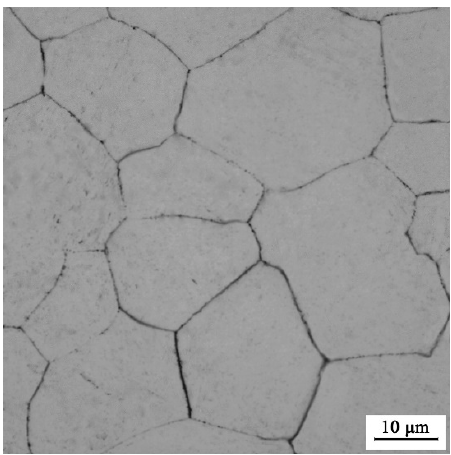
Figure 2. Schematic diagram of the hot compression test procedure.